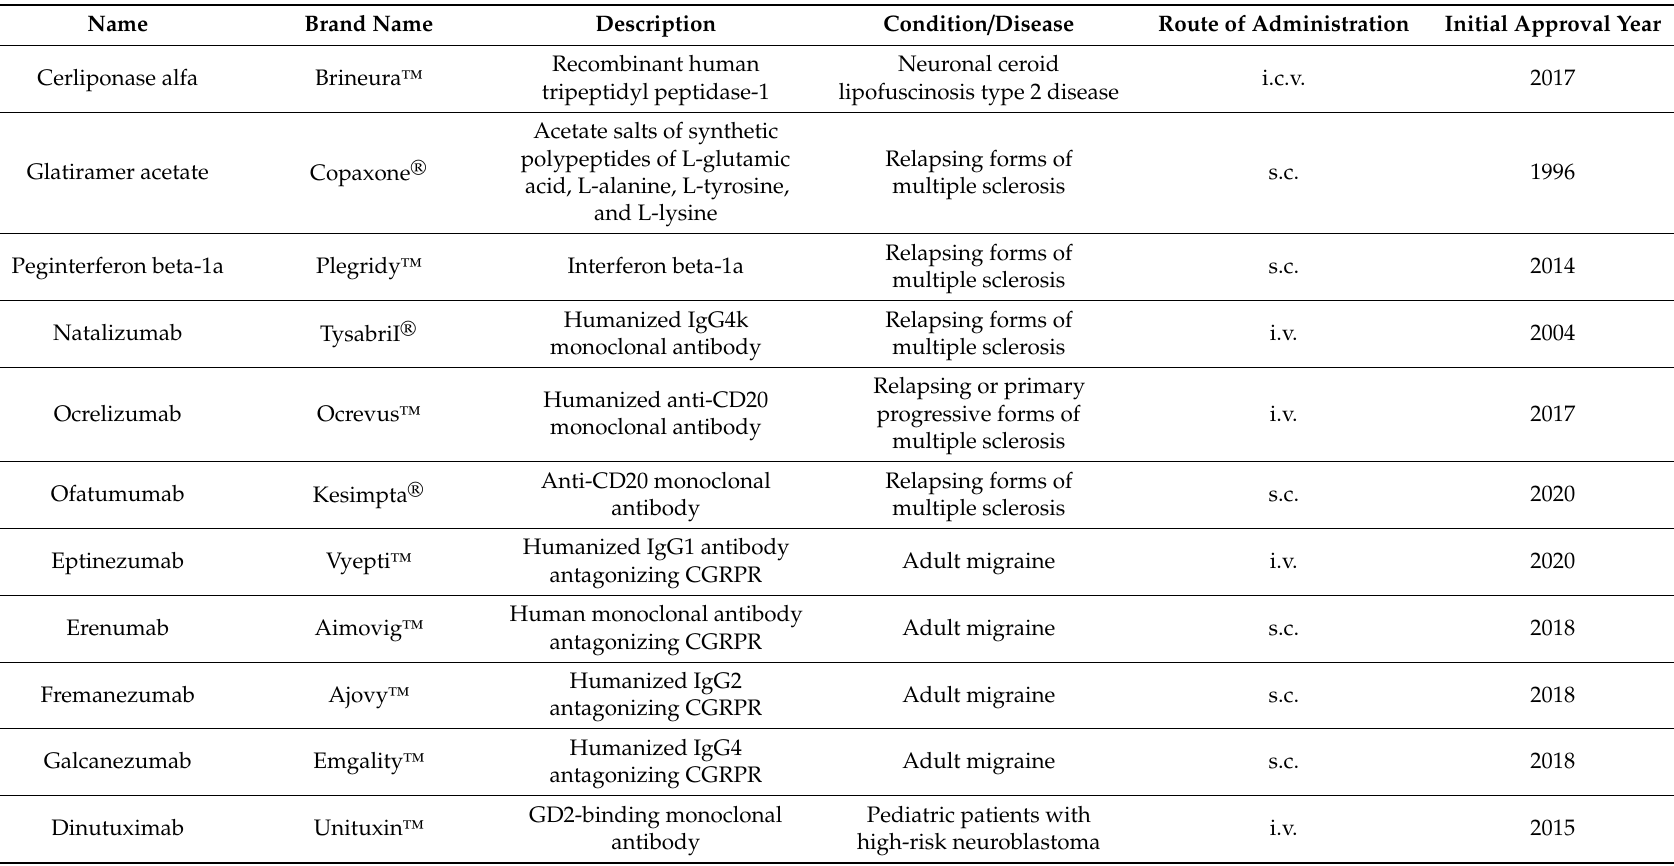
Table 2. Approved peptide / protein-based therapies for neurological